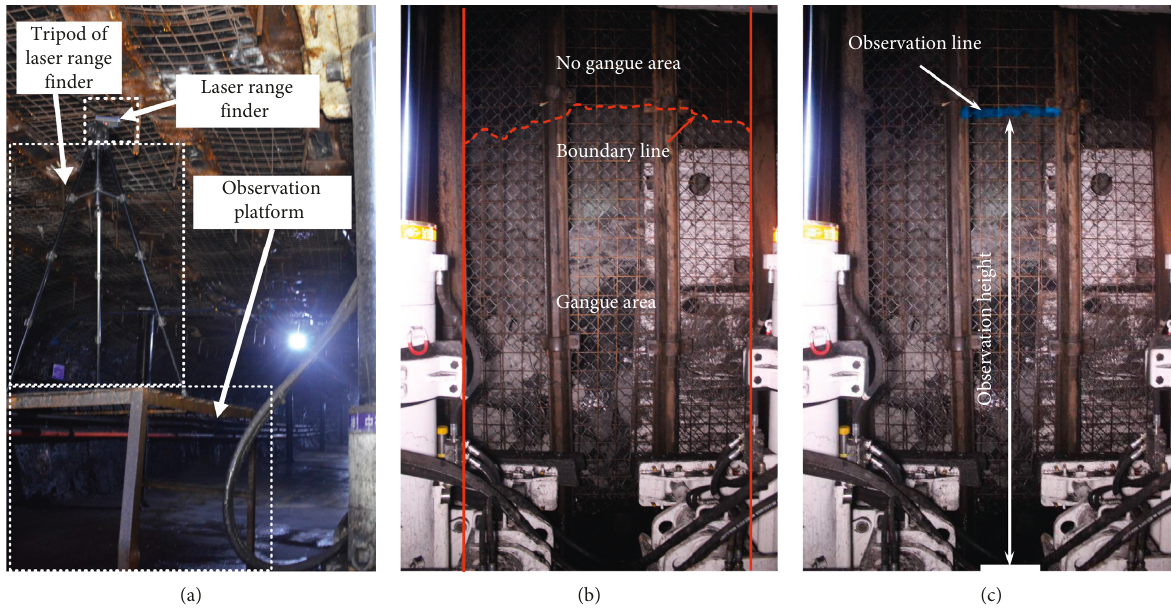
Figure 10: Field observation diagram relative to the study plan of the bulking coefficient. (a) Layout of the observation instruments. (b) Caving of gangue at the observation stations. (c) Observation line and height